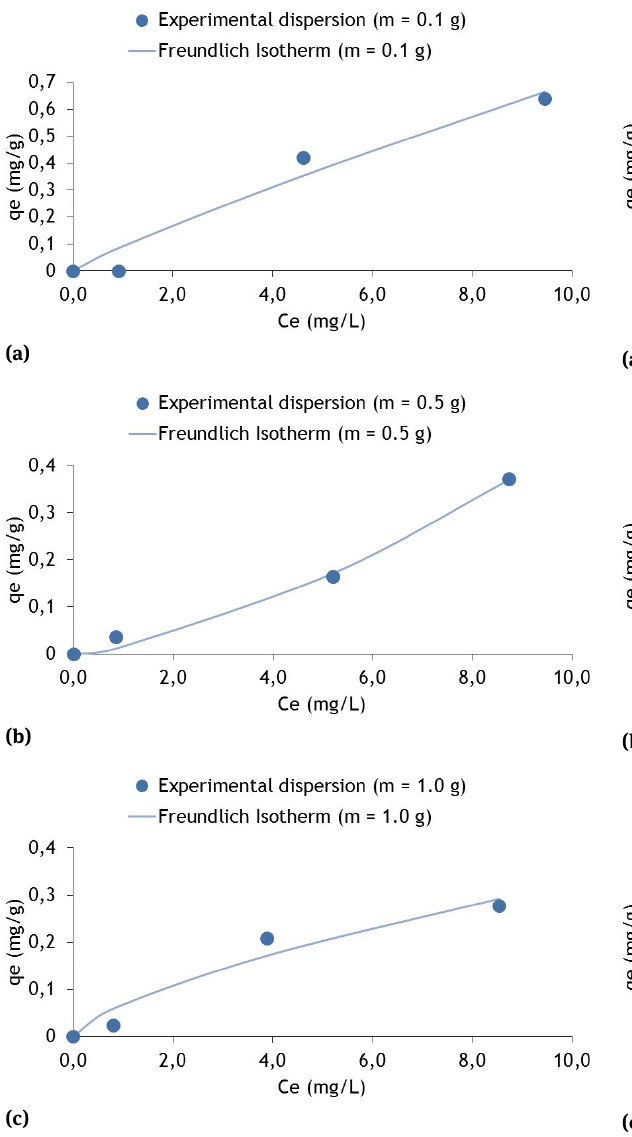
Figure 6: Sorption isotherms for the Freundlich model with Cu and soil masses of 0.1 g (a), 0.5 (b) and 1.0 g